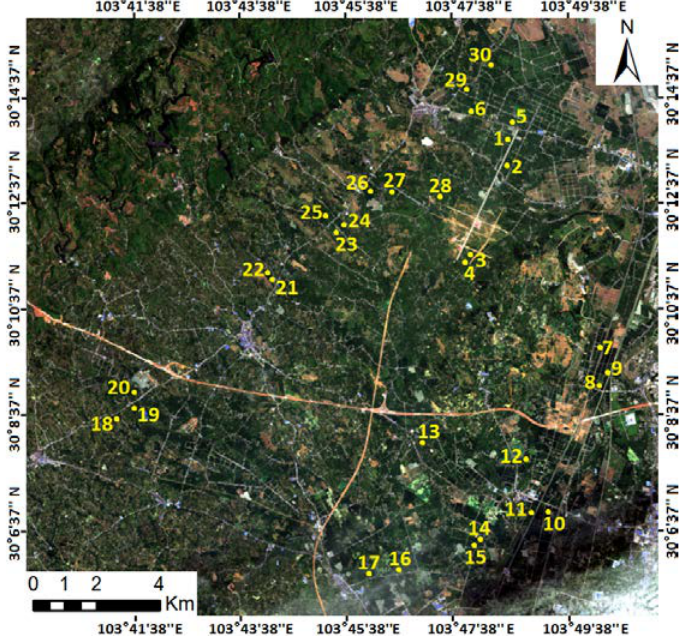
Figure 1. The study area imaged by the French SPOT-6 optical sensor on 15 July 2016. Thirty sample sites are located and numbered.